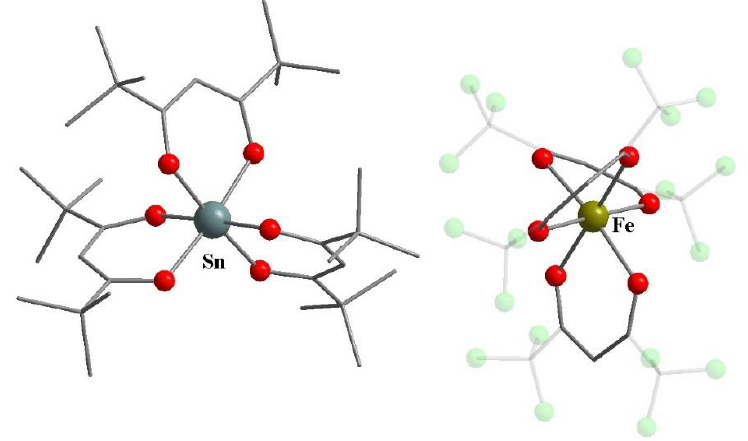
Figure 23. Molecular structure of 45 [91]. Hydrogen atoms have been omitted, CF 3 groups are transparent for clarity. The cif has been retrieved from CCDC. CCDC numbers is 1811494.